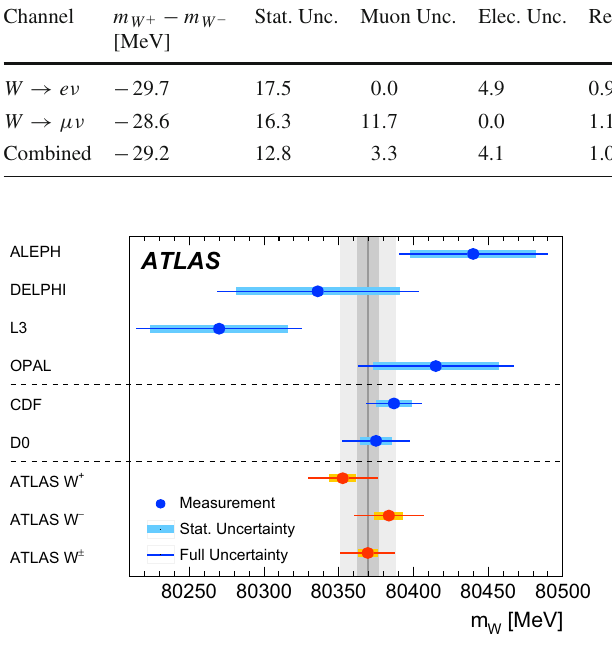
Fig. 28 The measured value of m W is compared to other published results, including measurements from the LEP experiments ALEPH, DELPHI, L3 and OPAL [25–28], and from the Tevatron collider exper- iments CDF and D0 [22,23]. The vertical bands show the statistical and total uncertainties of the ATLAS measurement, and the horizontal bands and lines show the statistical and total uncertainties of the other published results. Measured values of m W for positively and negatively charged W bosons are also shown